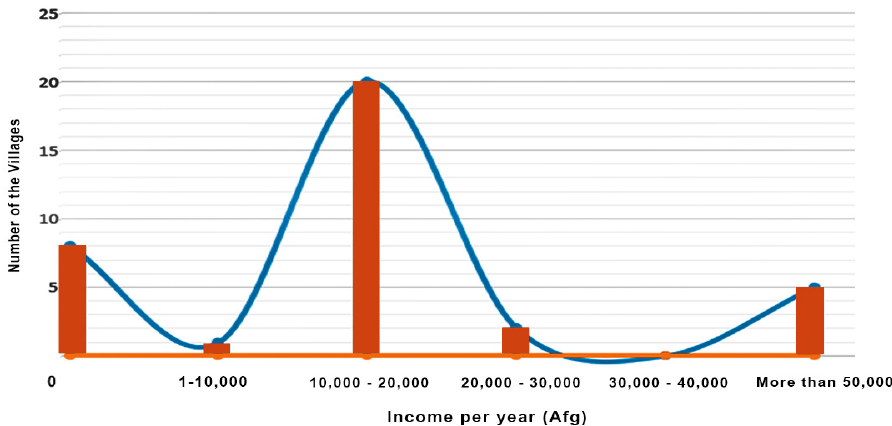
Table 10. Classification of the “Vacant area” index with their weights.